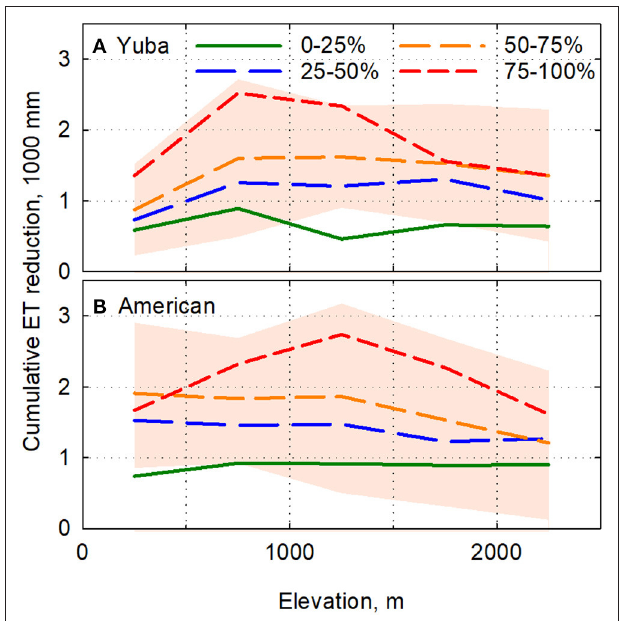
FIGURE 6 | Cumulative evapotranspiration (ET) reduction by fire-severity class and 500-m elevation bins for the (A) Yuba and (B) American watersheds for fires 1985–2013. Plus and minus one standard deviation is shown for the 50–75% basal area reduction class. Other standard deviations are similar.